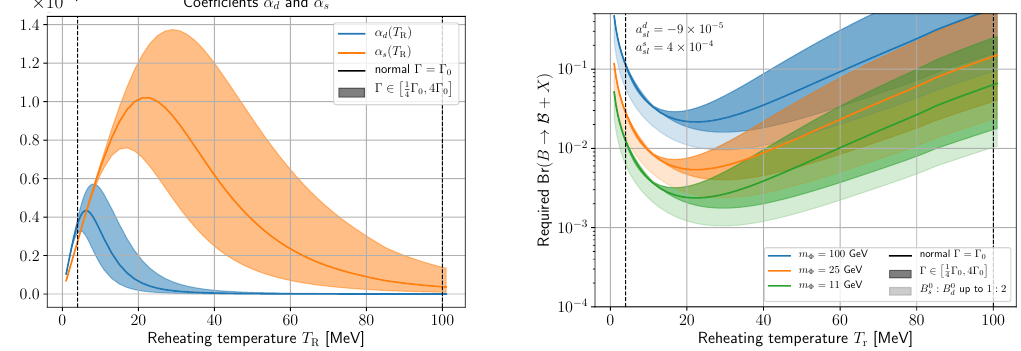
Figure 2. Left: values of the numerically determined functions (cid:11) d and (cid:11) s as a function of the reheating temperature over the range of interest 4{100 MeV, computed following the prescription of [41]. In order to account for the uncertainty in the calculation coming from the lack of precise knowledge of the scattering rate (cid:0) of e (cid:6) o(cid:11) B mesons in the primordial plasma, we conservatively allow for up to a factor of 4 uncertainty in (cid:0). This uncertainty mostly stems to the lack of knowledge about the charge radius of the neutral B mesons. Right: branching ratio of B mesons to visible baryons and dark antibaryons necessary to reproduce the baryon asymmetry of the Universe, also as a function of the reheating temperature. We use the largest experimentally allowed values for the semileptonic asymmetries and give the results for 3 di(cid:11)erent values of the mass of (cid:8). We use di(cid:11)erent shades of the colors to highlight uncertainties coming from the scattering rate as explained above and, additionally, from potential variations in the fragmentation ratio of b quarks to B 0 and s B 0 mesons [4] (we use a benchmark ratio of 1 : 4 but to be conservative allow it to be as large as d 1 : 2). In this range of parameters, branching ratios in the 0.001{0.1 range can lead to successful